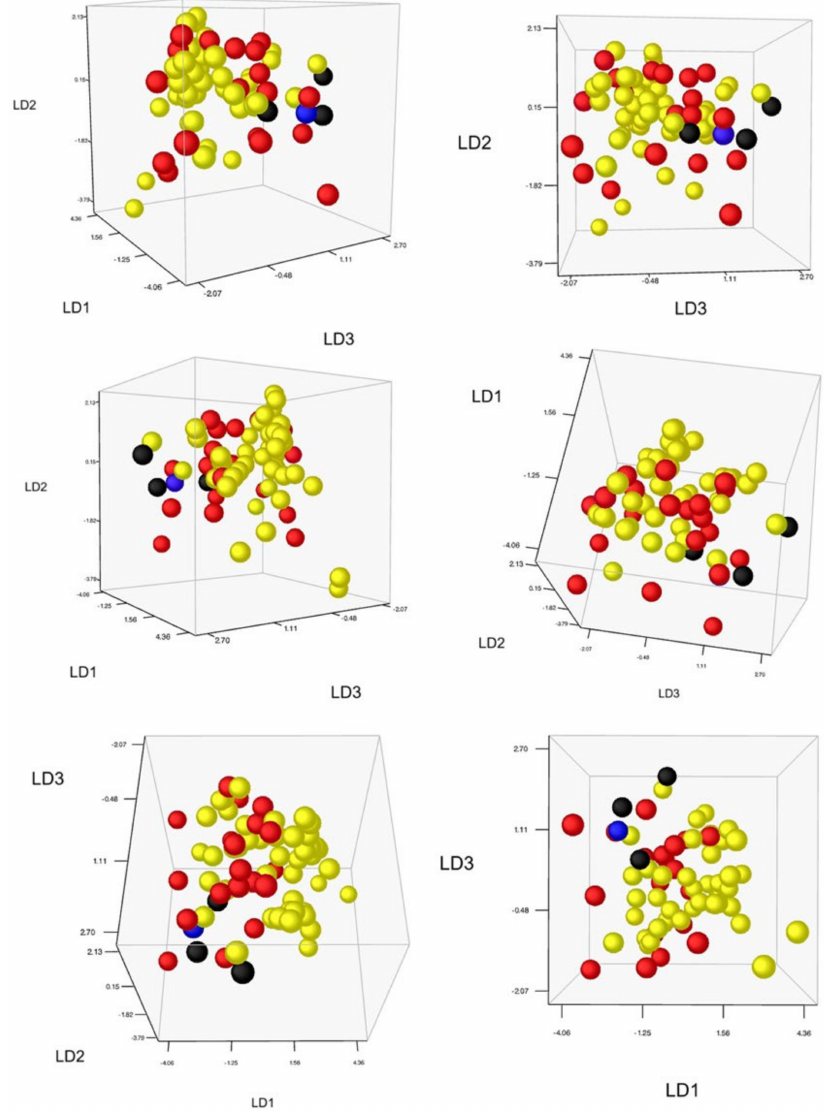
Figure 6. Discriminant analysis visualizing the general morphocloud pattern. Discriminant analysis results with 3D pattern reflecting general relationships between main groups. The inner core–outer envelope shows how the M. longifolia s.s.– suaveolens complex and the M. spicata complex, respectively, are mutually connected and at the same time also largely separated. The outer envelope contains accessions with sequences belonging to main clusters 1 (black) and 2 (red), while the inner core has sequences belonging to main cluster 4 (yellow). Note that the only morphologically analyzed accession with sequences from main cluster 3 (blue) is ordinated at the outer